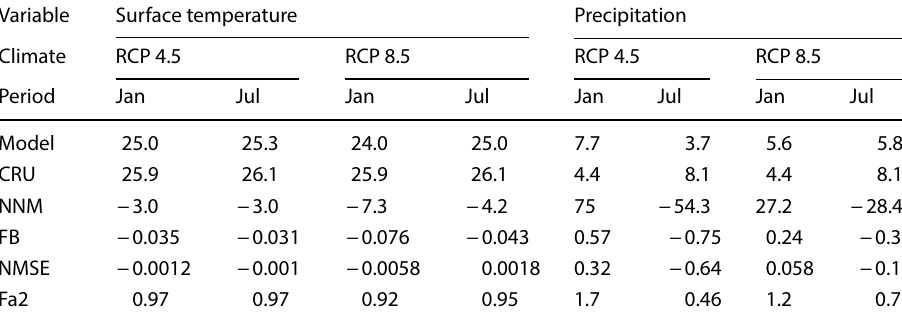
Table 4 Comparison of the surface temperature and total precipitation in January and July under RCP 8.5 and RCP 4.5 as relative to observed (CRU dataset) for normalized mean bias (NMB), fractional bias (FB), normalized mean square error (NMSE) and factor of two (Fa2)